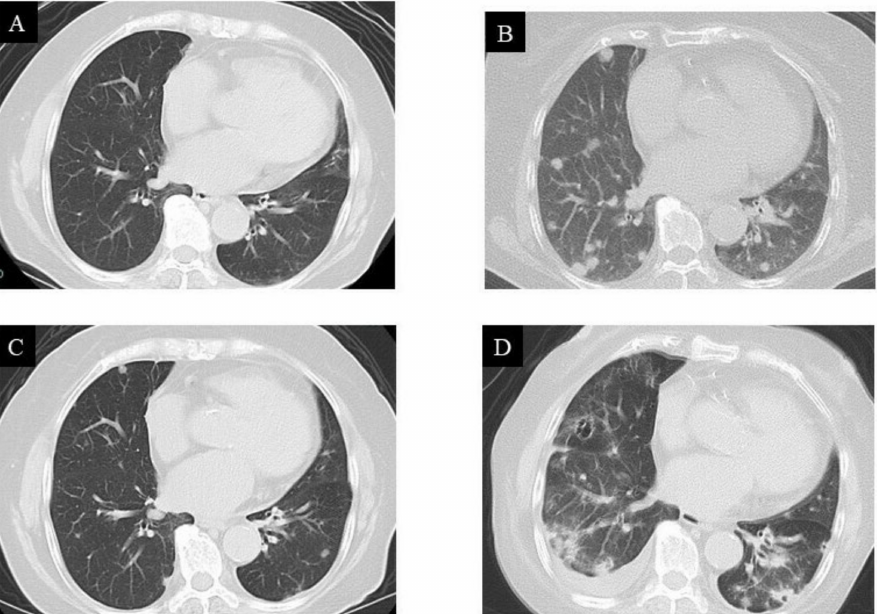
Figure 6. Computed tomography (CT) images of the lung: ( A ) no pulmonary metastases observed before treatment; ( B ) multiple pulmonary metastases observed three months after surgical resection; ( C ) metastases rapidly regressed after pazopanib treatment; ( D ) metastases recurred 11 months after pazopanib